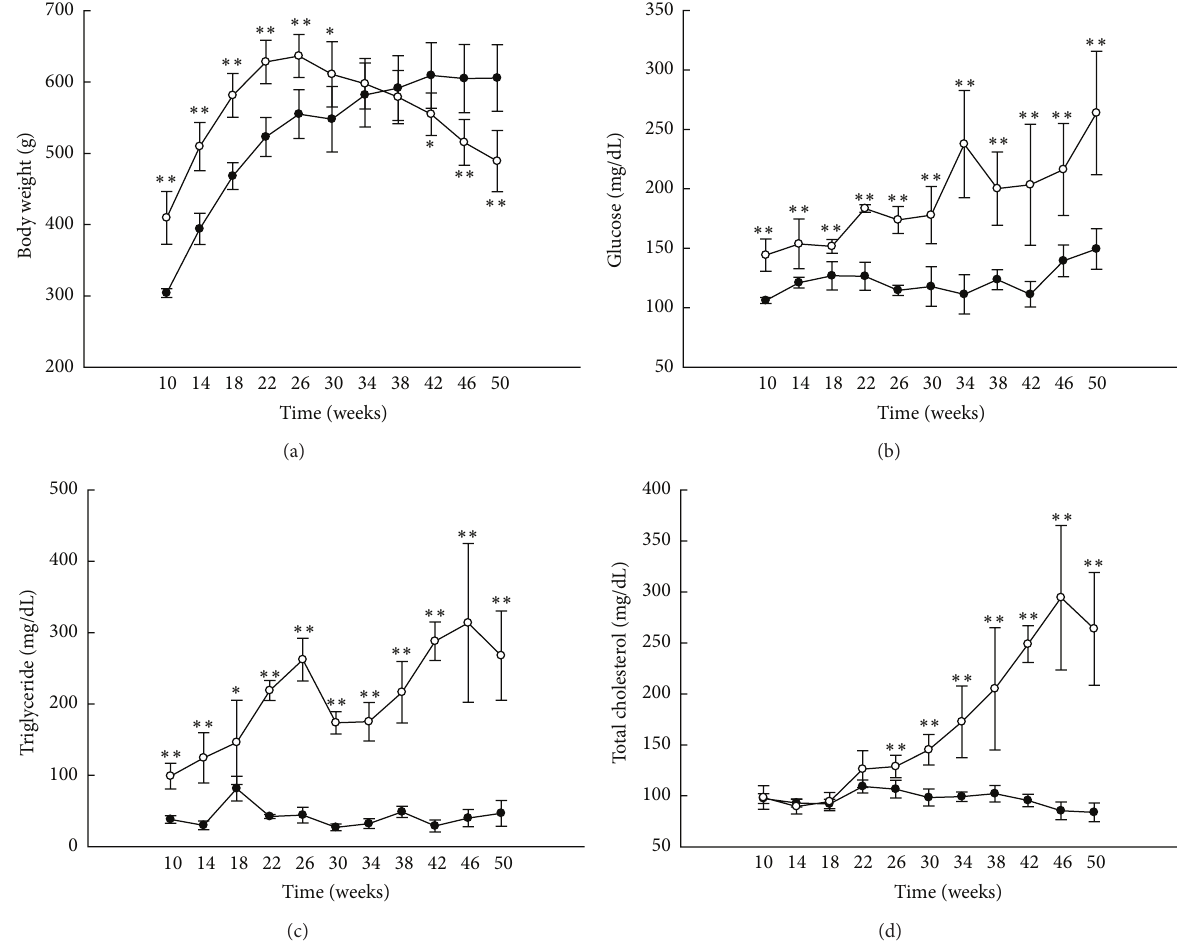
Figure 1: Animal characteristics and biochemical analyses. Body weights ((a), 𝑛 = 6 ) and serum glucose ((b), 𝑛 = 5 ), triglyceride ((c), 𝑛 = 5 ), and total cholesterol ((d), 𝑛 = 5 ) levels. White circles: OLETF rats; black circles: LETO rats. All data are expressed as means ± SD. ∗ 𝑃 < 0.05 , ∗∗ 𝑃 < 0.01 compared with LETO